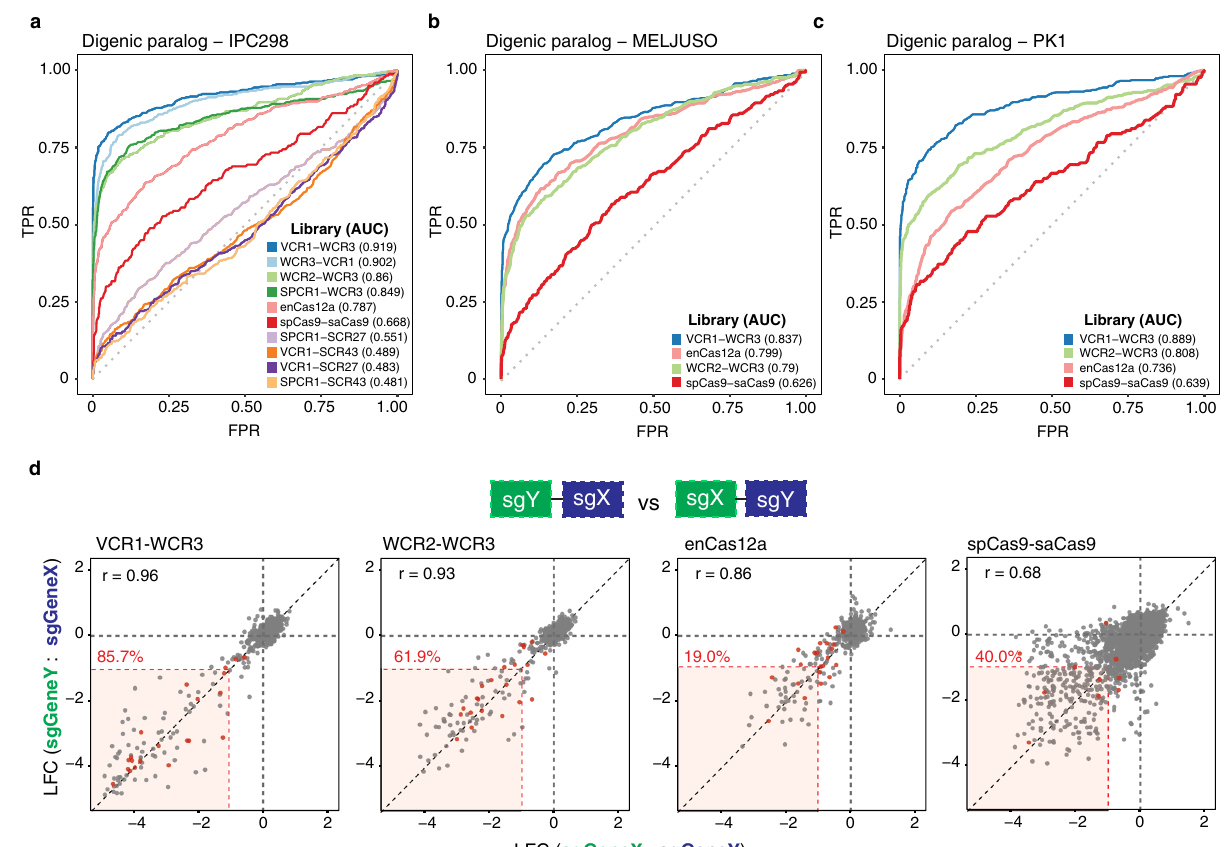
Fig. 4 Benchmarking of dual knockouts by pan-essential paralog pair. a – c The ROC-AUC curves derived from pan-essential and nonessential paralog pairs across distinct libraries in ( a ) IPC298, ( b ) MELJUSO, and ( c ) PK1. AUC values are indicated in parentheses. d Correlation between the average LFC of dual knockouts with inverted positions of sgRNAs in IPC298. Pearson ’ s correlation coef fi cient is indicated ( r value) in black. Percent of pan-essential paralog pairs with LFC less than − 1 for both sgRNAs in positions are indicated in red. Pan-essential paralog pairs are annotated by red dots. Source data are provided in the Source Data